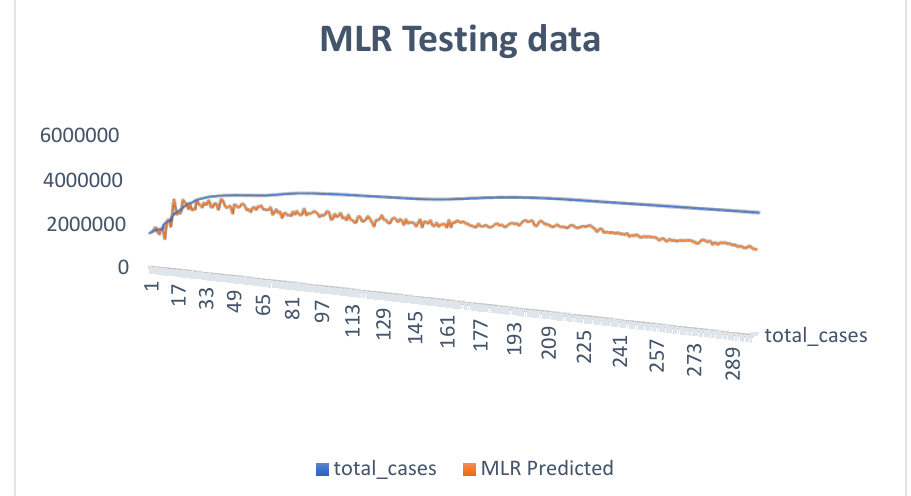
Figure 7: MLR training data showing experimental and predicted values.